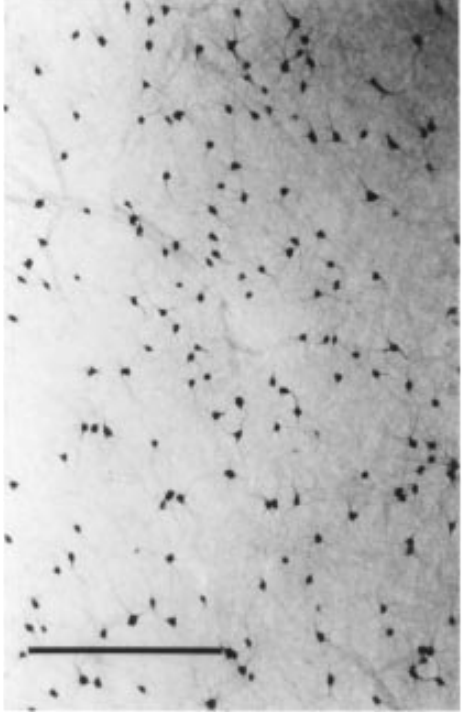
Figure 6 - Photomicrograph of cortical tissue cut tangentially at the white matter level. Numer- ous NADPH-diaphorase neurons seem to be distributed ran- domly, forming a net of consid- erable dendritic overlap. Scale bar = 500